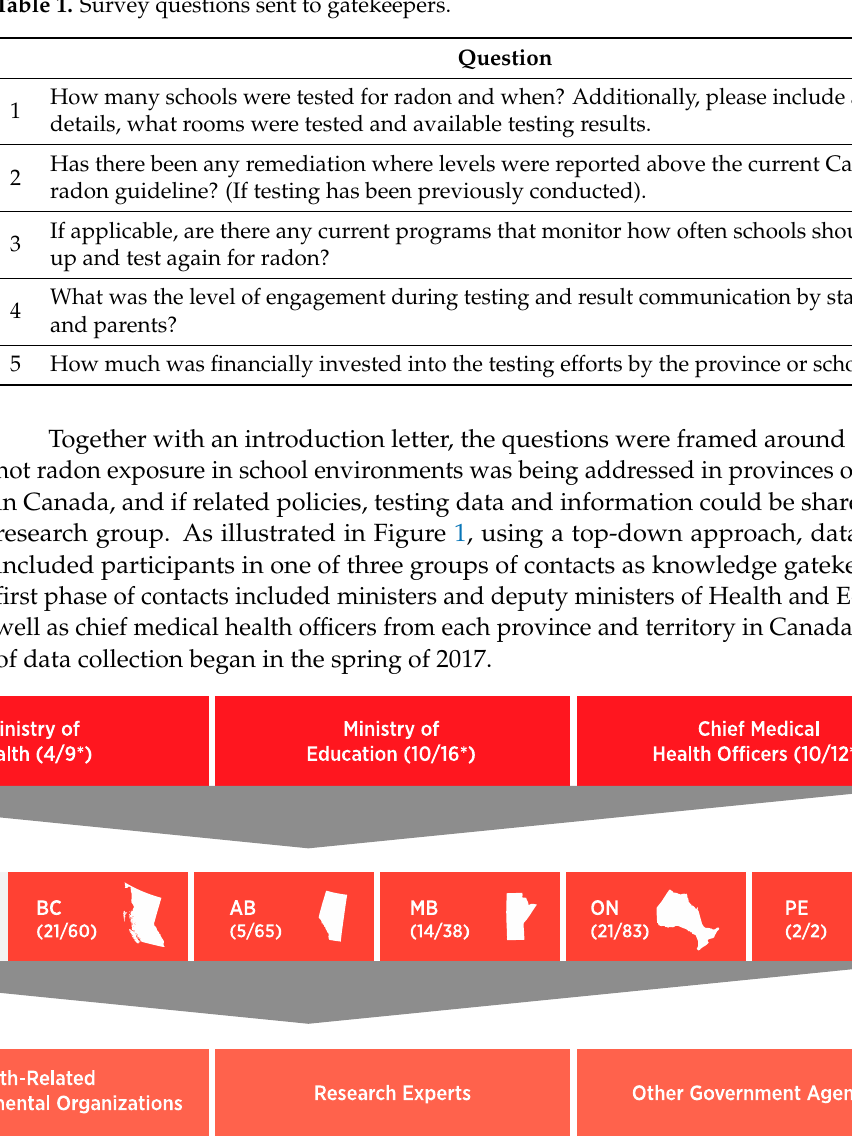
Table 1. Survey questions sent to gatekeepers.